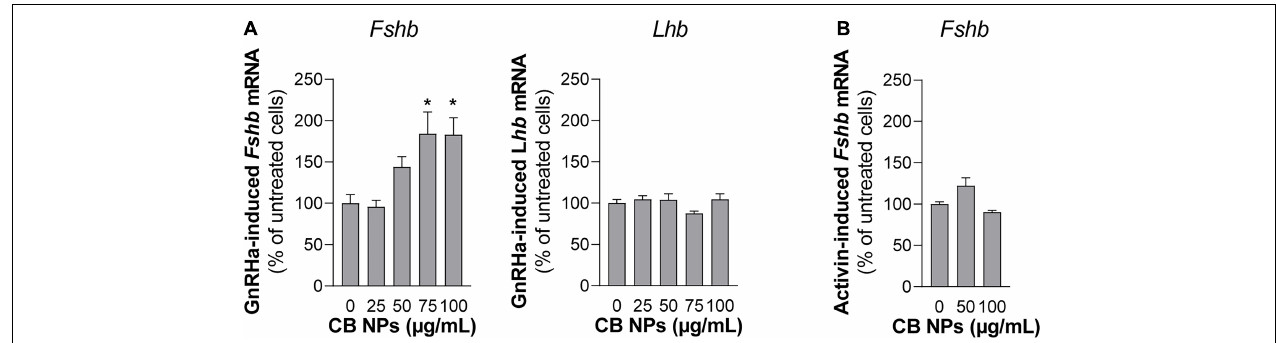
FIGURE 8 | Effects of CB NPs on GnRH agonist stimulation of Fshb and Lhb expression in L β T2 cells. L β T2 cells were cultured for 24 h with increasing concentrations (25–100 µ g/mL) of CB NPs, washed and incubated or not for an additional 6 h with the GnRH agonist Triptorelin [GnRHa, 100 nM; (A) ] or Activin A [10 ng/mL; (B) ]. Total RNAs were extracted, and Fshb and Lhb mRNA levels were determined by real-time quantitative PCR as indicated in Materials and Methods. Data are expressed as percentage over GnRHa (A) or Activin A (B) stimulation in absence of CB NPs and are the mean ± SEM from 3 to 6 independent experiments. Statistical differences were determined by non-parametric Kruskal-Wallis test followed by Dunnet’s multiple comparison test. * p < 0.05 compared to no CB NPs.